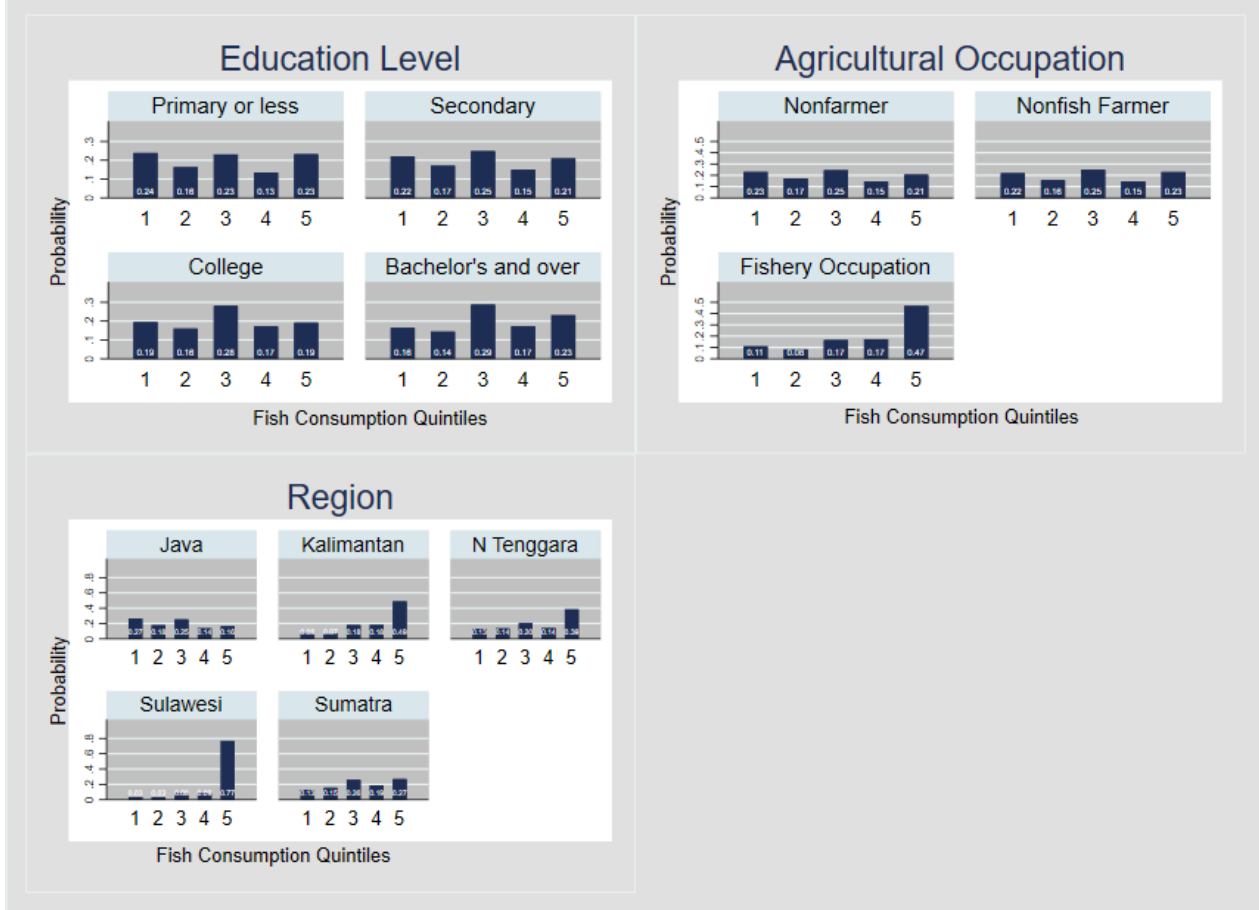
Figure 3. Bar charts showing the predicted probabilities of being in each fish consumption quintile by educational level, involvement in fishery, and region.